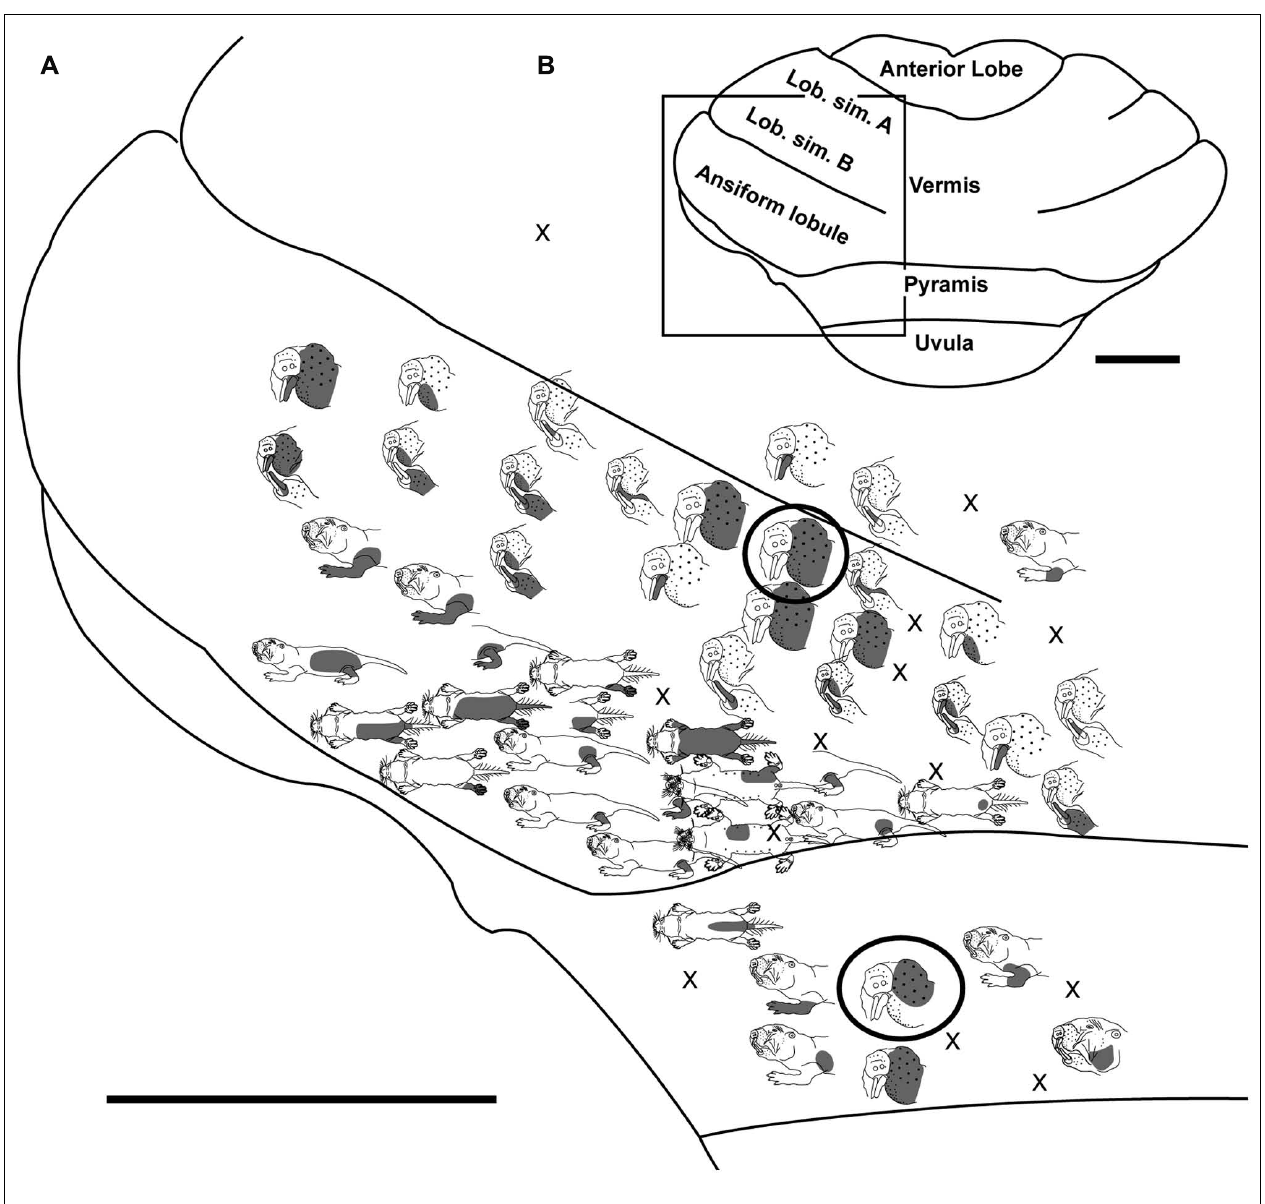
FIGURE 3 |Topography of the naked mole-rat cerebellum with electrophysiological mapping of cutaneous and periodontal responses from the lobulus simplex B, vermis, ansiform lobule, and pyramis. (A) Schematic of the microelectrode-derived map of cutaneous inputs to the cerebellum labeled according to corresponding receptive fields. Dark circles